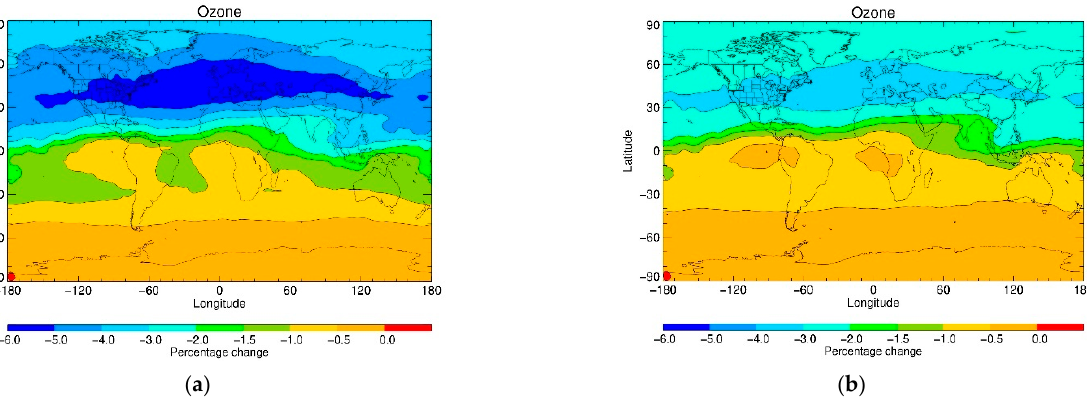
Figure 5. The percentage change of ozone mixing ratios at 11.8–16.2 km (201–100 hPa) from ( a ) STOCHEM-base to STOCHEM-75NO x scenario, ( b ) STOCHEM-base to STOCHEM-50NO x scenario. Reduced NO x mixing ratios are shown to greatly reduce quantities of OH present